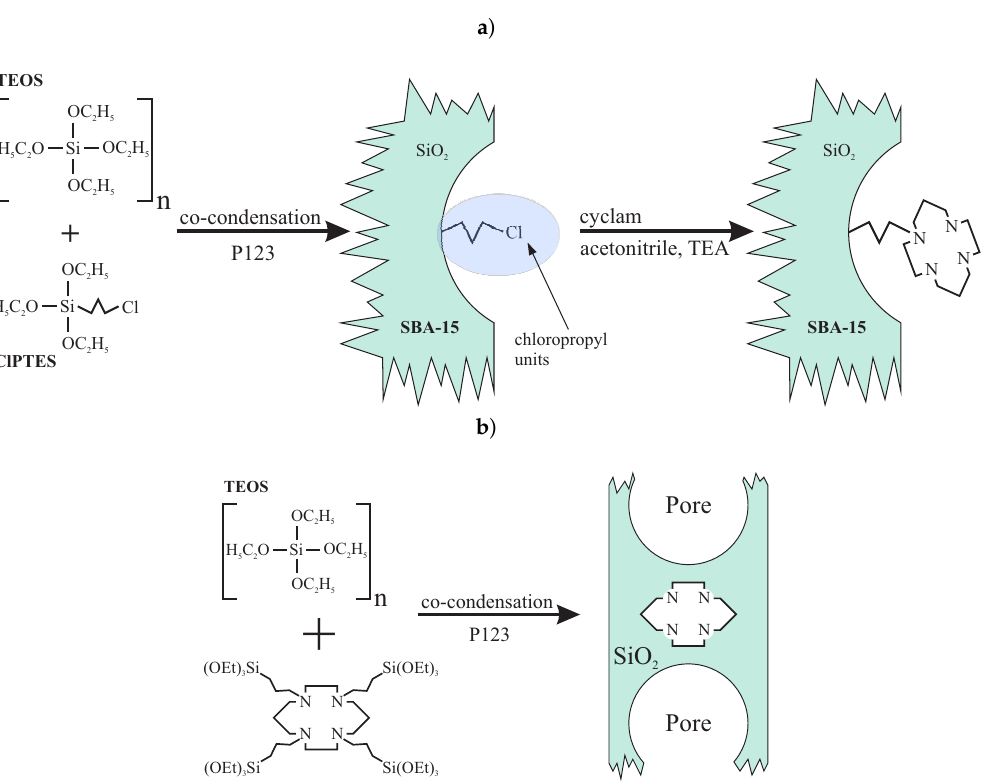
Figure 24. The synthesis routes for the SBA-15 silica containing cyclam molecules attached inside silica pores via propyl chains ( a ) and incorporated inside the structure of silica ( b